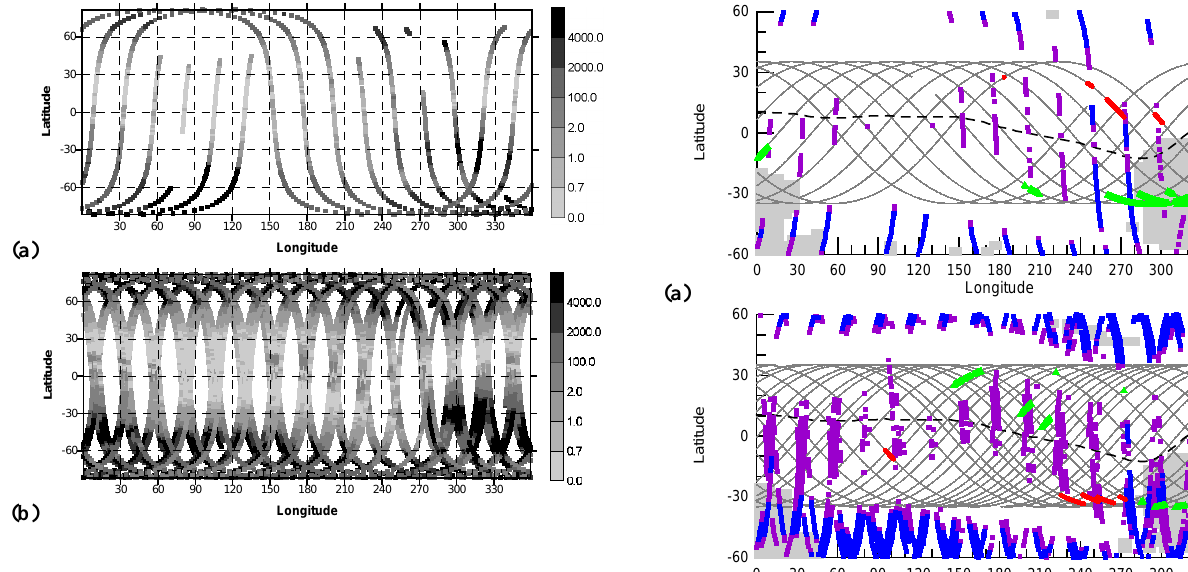
Fig. 8. Fluxes of > 0.6 electrons and > 0.8 protons measured by the SAMPEX/LEICA during the great geomagnetic storms on 15– 16 July 2000 (a) and 29–31 October 2003 (b) . The intensities are indicated in a gray scale from < 0.7cm − 2 s − 1 sr − 1 (light gray) up to 10 5 cm − 2 s − 1 sr − 1 (black).